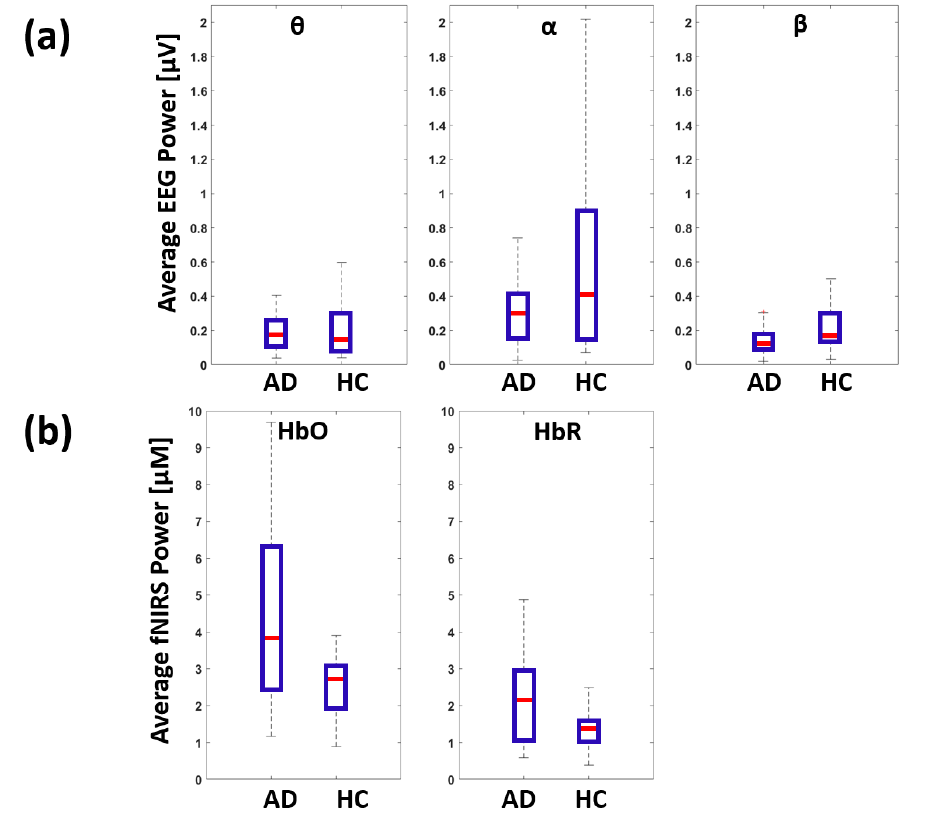
Figure 6. Boxplots showing the EEG and fNIRS average power for AD and HC. ( a ) Global EEG power in theta ( θ ), alpha ( α ) and beta ( β ) bands. ( b ) Global fNIRS power in HbO and HbR timecourses.